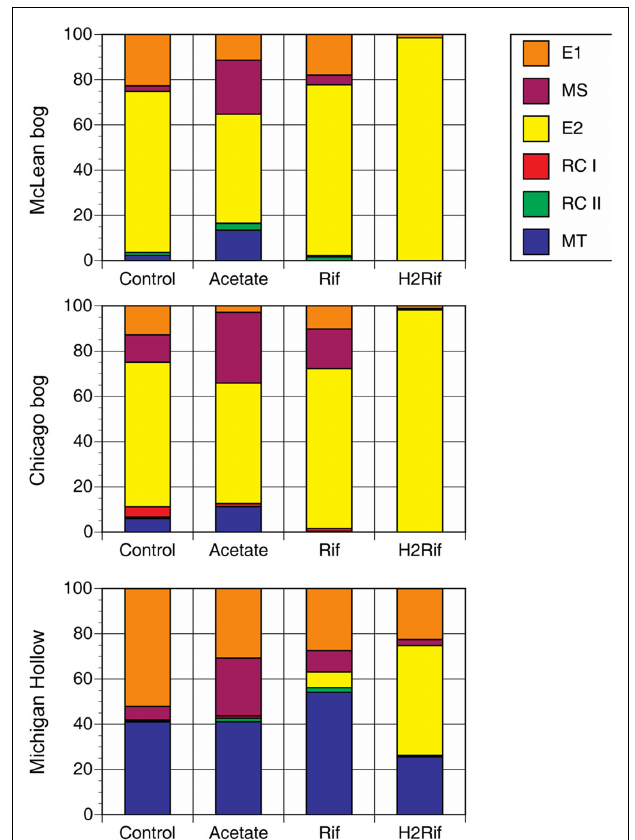
FIGURE 2 | Proportion of major methanogen groups determined by T-RFLP of SSU rRNA gene sequences for soil samples from three peatlands. Analysis was performed after in vitro incubation with one of four treatments: Control with no addition; Acetate with added acetate (1mM); Rif with added rifampicin; and H2Rif with added H 2 and rifampicin. Legend indicates groups: E2 (cid:2) (E2) and E1 (cid:2) (E1) in the order Methanomicrobiales; rice cluster-I (RC-I) in the novel order Methanocellales; uncultivated RC-II; and, Methanosarcinaceae (MS) and Methanosaetaceae (MT) in the